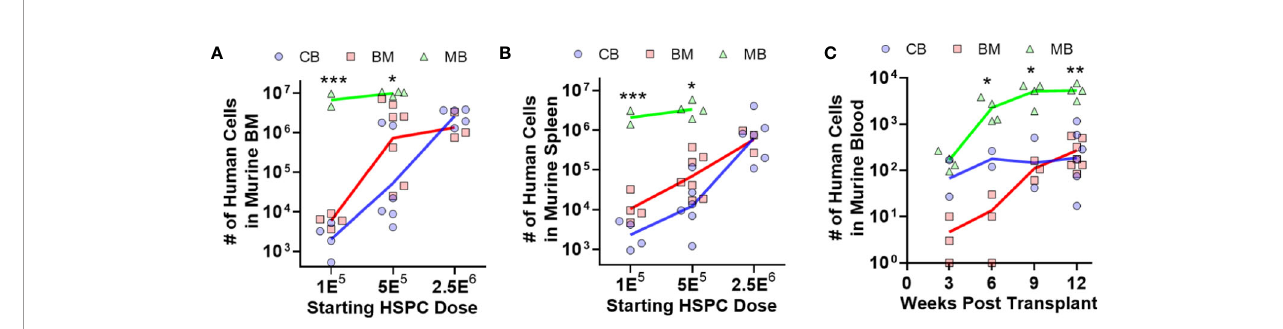
FIGURE 3 | Human hematopoietic output is dependent on HSPC dose. The relative abundance and kinetics of human HSPC expansion in NBSGW mice was determined for each graft source. (A) Total number of human cells in the bone marrow collected from one leg (femur + tibia) at 12 weeks post-transplantation according to the starting HSPC dose. Symbols show individual mice that received HSPCs isolated from CB (blue), BM (red), or MB (green), with lines indicating geometric means. (B) Total number of human cells in the murine spleens at 12 weeks post-transplantation. (C) Total number of human cells in 100 m l of murine peripheral blood, collected at the indicated times post-transplantation. Results are from transplantation of 5E 5 HSPCs. *p < 0.05; **p < 0.01; ***p <